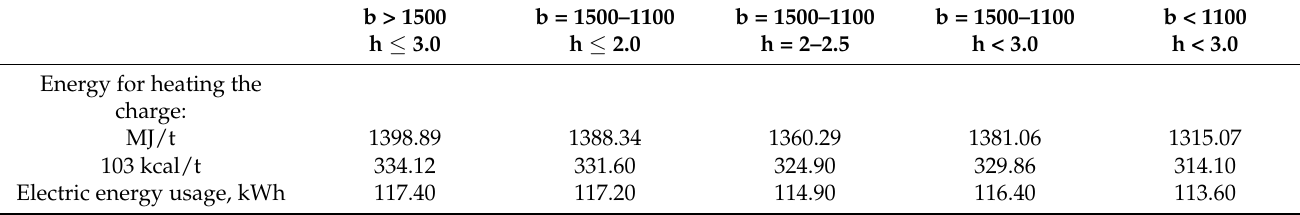
Table 6. Examples of calculations of energy consumption depending on the implementation of the rolling program. b > 1500